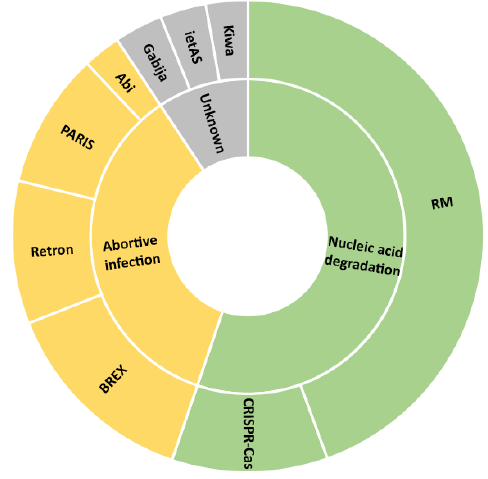
Figure 1. Presence of anti-phage defense systems in S. Typhimurium. The inner circle represents the mechanism type of anti-phage defense systems as cat- egorized by Nitzan Tal and Rotem Sorek [27]. The outside circle represents the name of the defense systems. Only defense systems identified in >10% of the genome sequences are represented. RM: restriction modification; CRISPR: clustered regularly interspaced short palindromic repeats; BREX: bacteriophage exclusion; PARIS: phage anti-restriction- induced system; Abi: abortive infection.